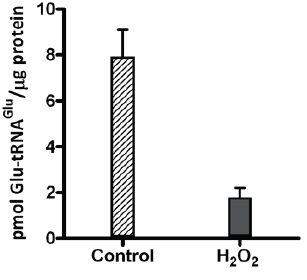
Figure 1. Glutamyl-tRNA synthetase 1 (GluRS1) activity in A. ferrooxidans